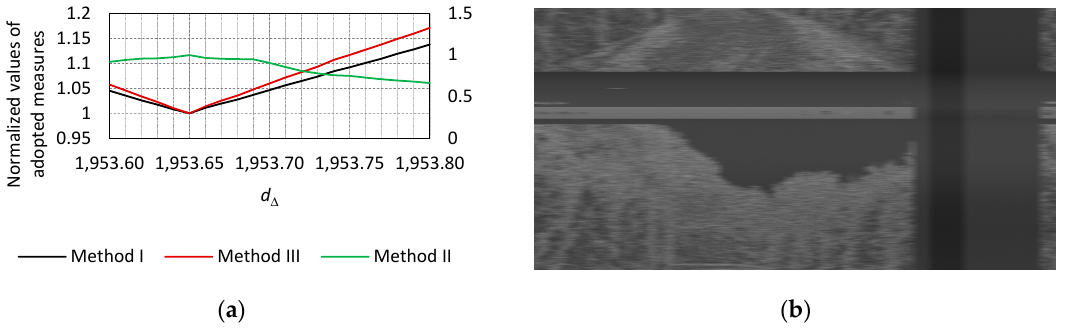
Figure 14. ( a ) The normalized values of the adopted measures (method I, II and III) calculated in domain of image line length d ∆ for the accuracy ∆ = 0.01 (for the original image shown in Figure 7a) and ( b ) image reconstructed on the basis of the recorded revealing emission signal at frequency f o = 1334 MHz (receiving bandwidth BW = 50 MHz) for estimated line length d ∆ = 1953.65000 (accuracy ∆ = 0.01)—multiple of image summation Sum MTL = 30, the source of revealing signal emission—display monitor, HDMI standard.